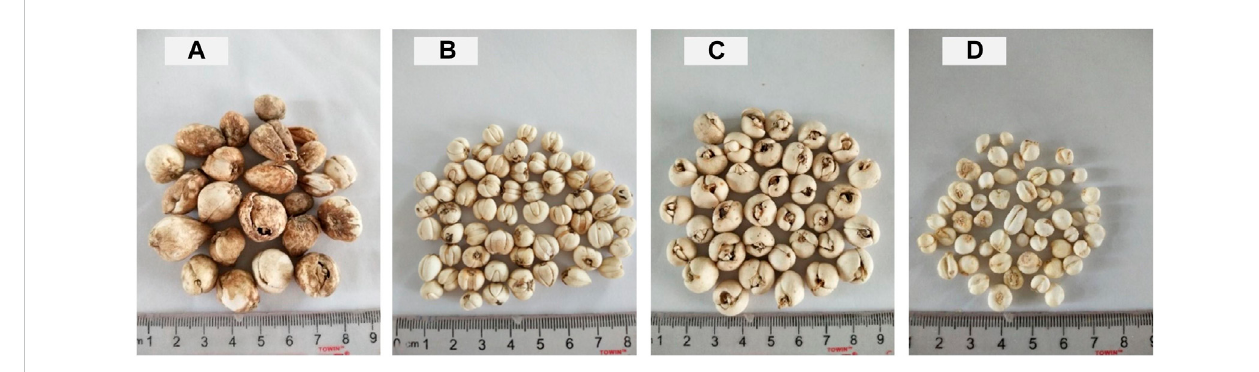
FIGURE 1 Samples plot: sample15, FU (A) ; sample38, FP (B) ; sample50, FD (C) ; sample73, FUS (D)